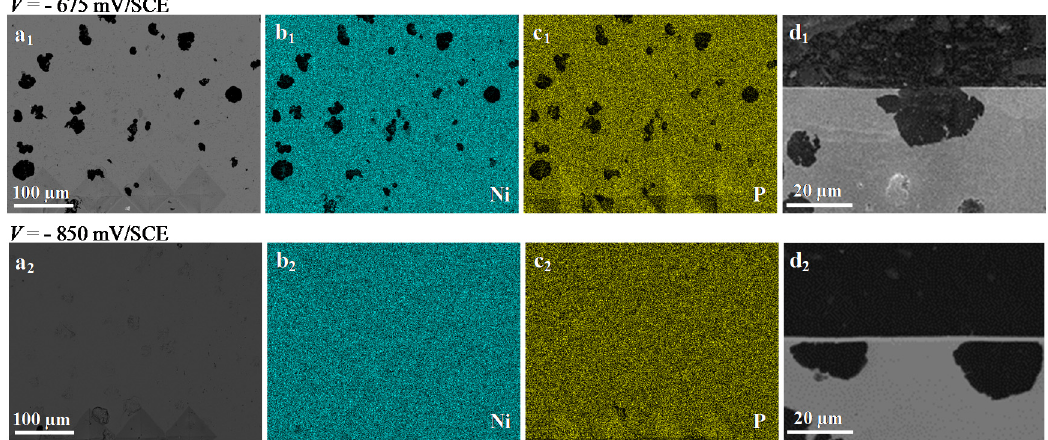
Figure 10. Ni-P Coating obtained on the SG cast iron after a 5 min experiment, including two steps. Step one: 3 min of polarization (V). Step two: 2 min at T = 84 ◦ C. ( a ) SEM top-view observation (BSE detector); ( b ) nickel EDX mapping analysis ( k α = 7.47 eV); ( c ) phosphorus EDX mapping analysis ( k α = 2.01 eV); and ( d ) cross-sectional-view observation (SE detector).